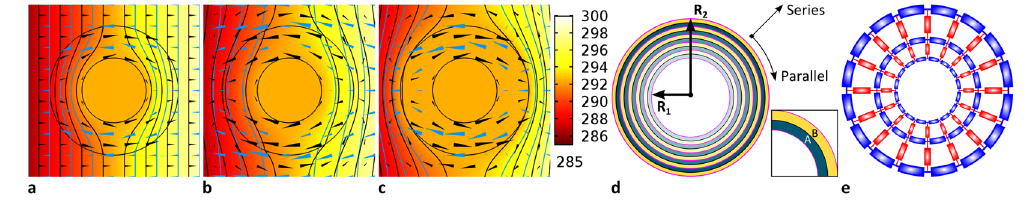
r 1 ; σ σ ′ = ; θθ − r r R 1 1 and outer radius R 2 . The bilayers